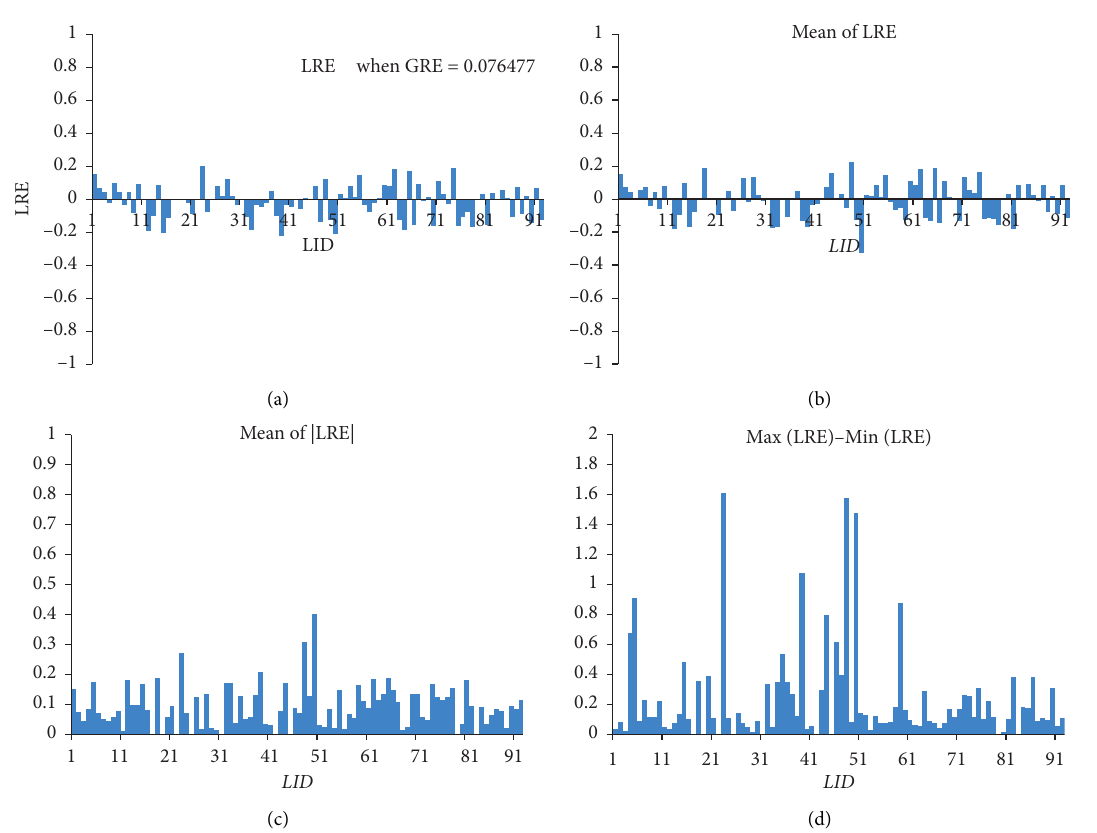
Figure 17: (a) LRE of each lake. (b) The mean LRE of each lake. (c) The mean of the absolute value of LRE of each lake. (d) The difference between maximum and minimum of LRE of each